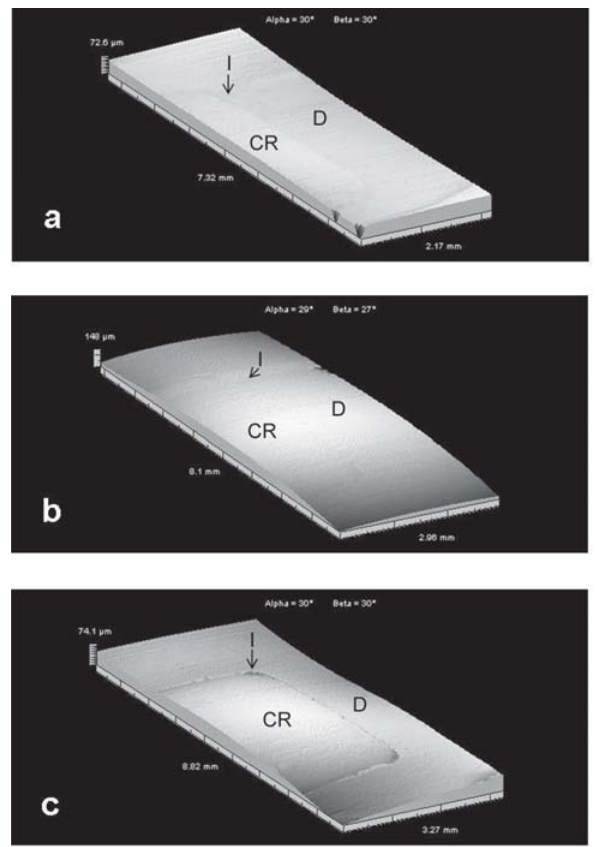
FIGURE 4- Representative photomicrographs of the specimens. In (a) and (b), cavities with 1 mm depth (C- factor 1.8) and 2 mm depth (C-factor 2.6), respectively. No gap formation was observed at the tooth-composite resin interfaces. In (c), a cavity with 3 mm depth (C-factor 3.4). Gap formation can be observed along the tooth-composite resin interface. (D) dentin; (CR) composite resin; (I)